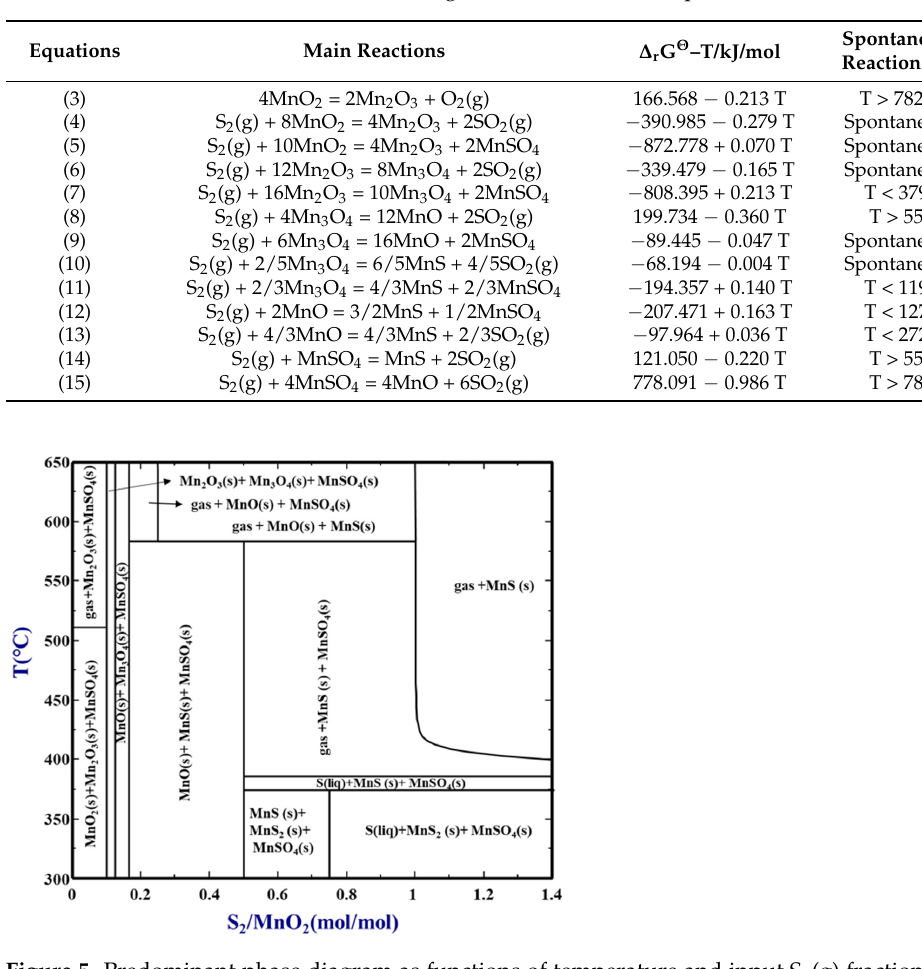
Table 2. Main reactions and their Gibbs energies as a function of temperature.